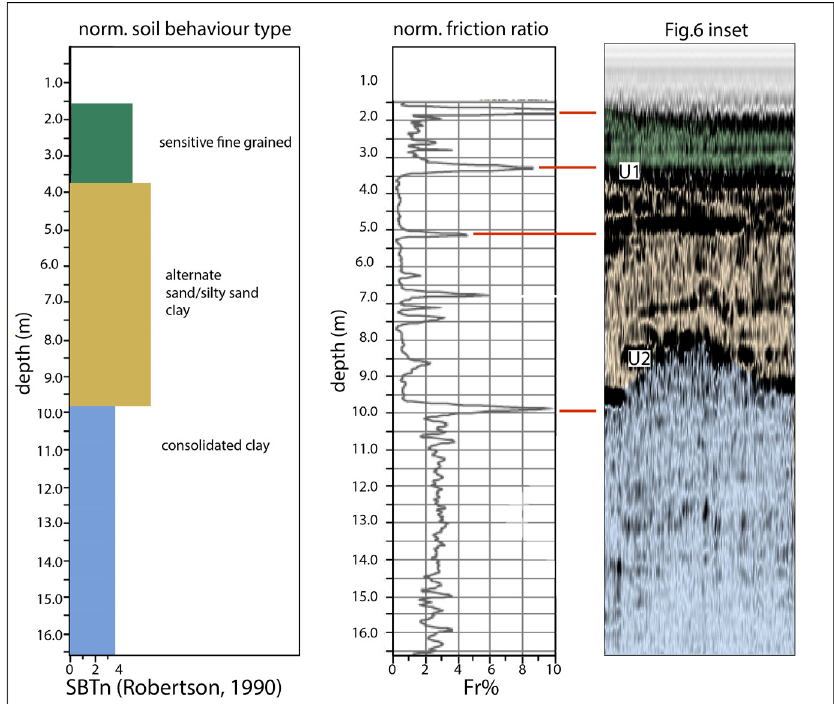
Figure 7. Stratigraphic correlations of seismic units and unconformities U1 and U2, resulting from CPTu tests [48]. We note how peaks in the normal friction ratio % fit with strong reflectors, indicating the presence of high acoustic impedance contrasts.